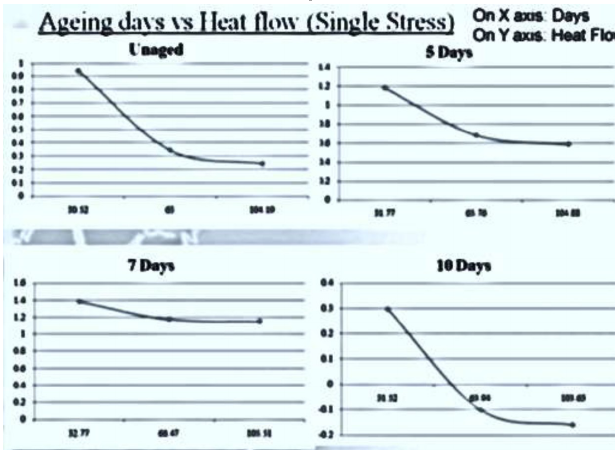
FIG. 18. AGEING DAY’S VS. HEATING (SINGLE STRESS) RESPECT TO HEAT FLOW